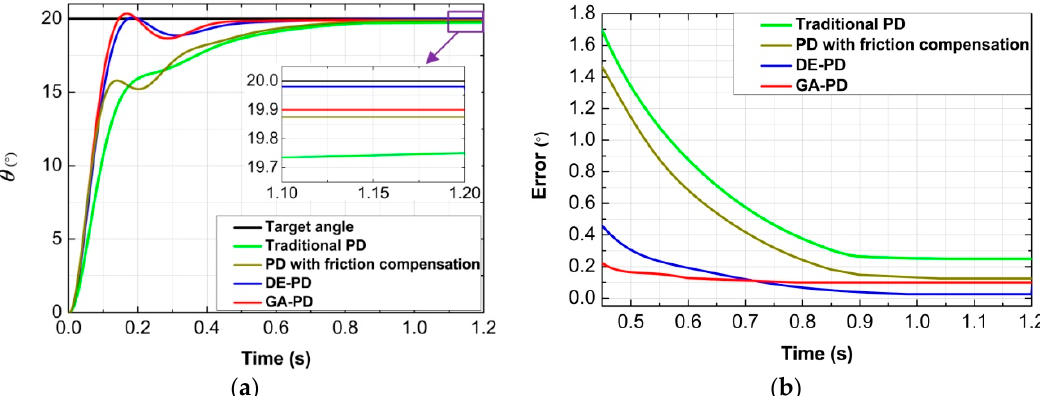
Figure 16. Positioning performance in the stability experiment. ( a ) Angle contrast curve; ( b ) error contrast curve.